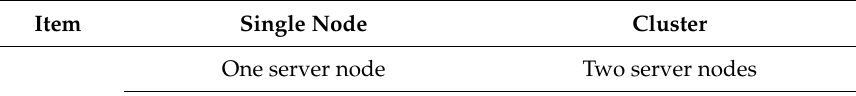
Table 4 lists testing items as well as examples. Table 3. Performance evaluation